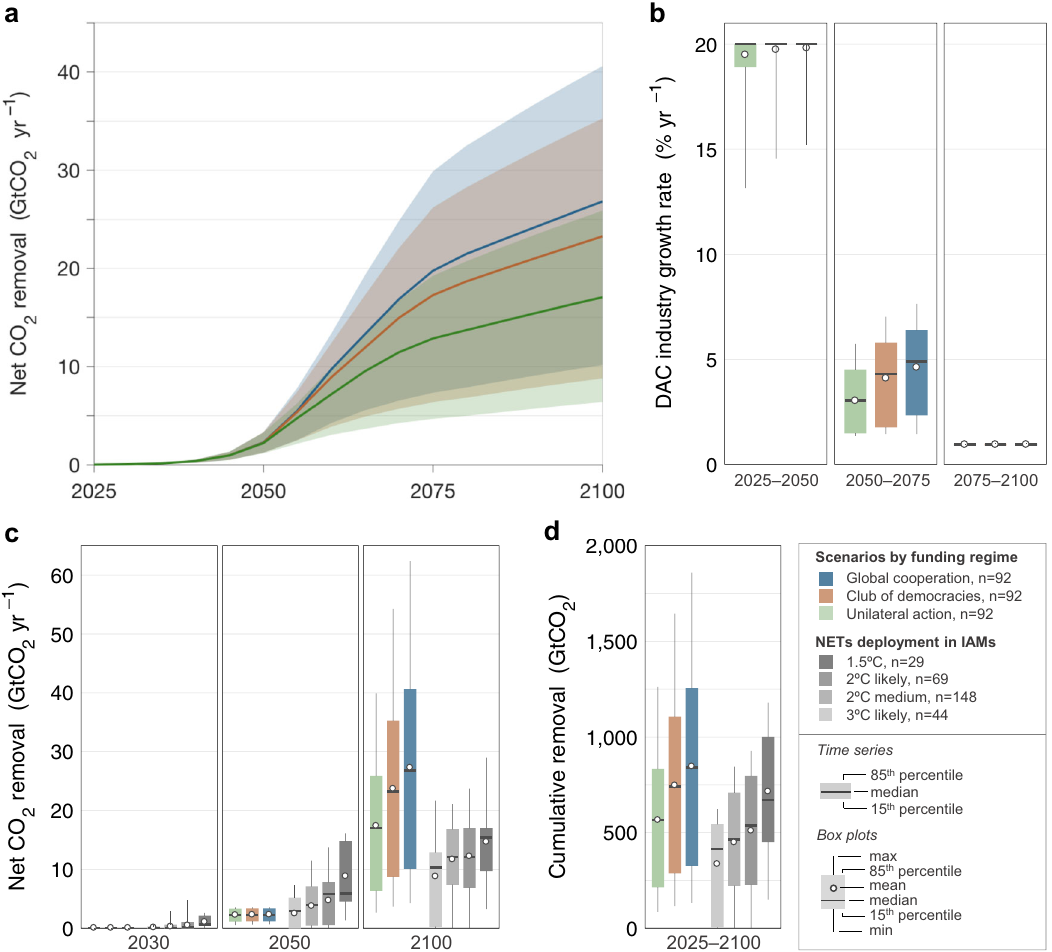
Fig. 3 Net CO 2 removal by funding regime. a Net CO 2 removal (i.e., gross removal less process emissions from energy supply) over 2025 – 2100. Colors denote the funding regime; ribbons indicate the 15th and 85th percentile scenarios; solid lines show the median. b DAC upscaling rate, given as the